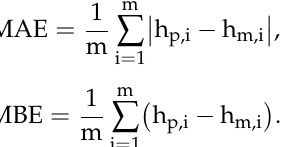
ment period (Figure 5) from 5.373 W/m 2 K (at 16:40 on 3 February) to 5.516 W/m 2 K (at 21:00 on 31 January), with an average of 5.445 W/m 2 K. The EN ISO 6946 standard [50] gives the value h r = 5.7 W/m 2 K for the blackbody at 20 ◦ C. Consequently, for ε = 0.95 resulting h r = 5.415 W/m 2 K is very close to that average value.